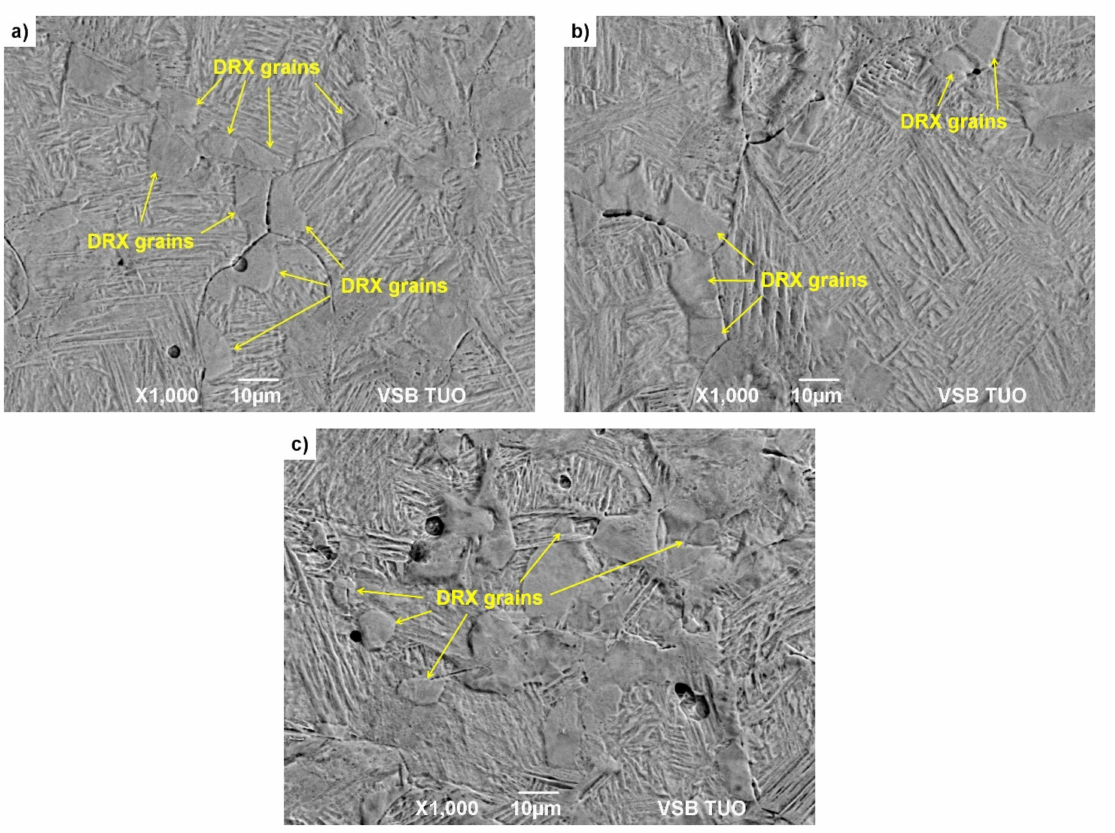
Figure 10. Metallographic images with etched boundaries of original austenitic grains of steel